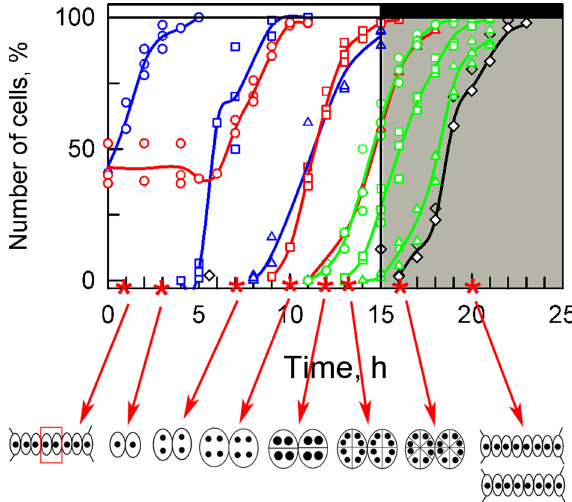
Figure 1. Dynamics of growth and the cell cycle in synchronized cultures of D. quadricauda . Upper part: Time courses of individual commitment points, nuclear division, protoplast fission and daughter cell release. Blue lines: cumulative percentage of cells that attained the commitment point for the first (circles), second (squares) and third (triangles) reproductive sequences, respectively; red lines: cumulative percentage of cells, in which the first (circles), second (squares), and third (triangles) nuclear divisions were terminated; green lines: cumulative percentage of cells, in which the first (circles), second (squares) and third (triangles) cell divisions were terminated, respectively; black line, empty diamonds: percentage of cells that released daughter coenobia. Light (15 h) and dark periods (9 h) are marked by stripes above panels and separated by vertical lines. The lines represent the means of at least three independent experiments. The raw values are plotted as dots and the line connects the mean values of the experiments. All values were calculated per parental cell, even after their division (17:00 to 22:00 h). Lower part: Schematic representation of the cells at the time-points (denoted by red asterisks) corresponding to the set of samples analyzed by Raman microscopy in Figure 4 (full set of Raman measurements is available in Figure S5). Schematic pictures of the cells indicate changes in their sizes. The full circles inside illustrate the ploidy and number of nuclei during the cell cycle. Larger circles indicate a doubling of DNA. For more details see text.